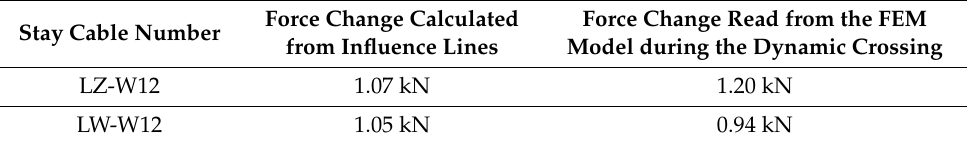
Table 9. Comparison of tension force changes in one strand of LZ-W12 and LW-W12 cables calculated according to the influence line and with the modelled dynamic passage of a 40 t vehicle.